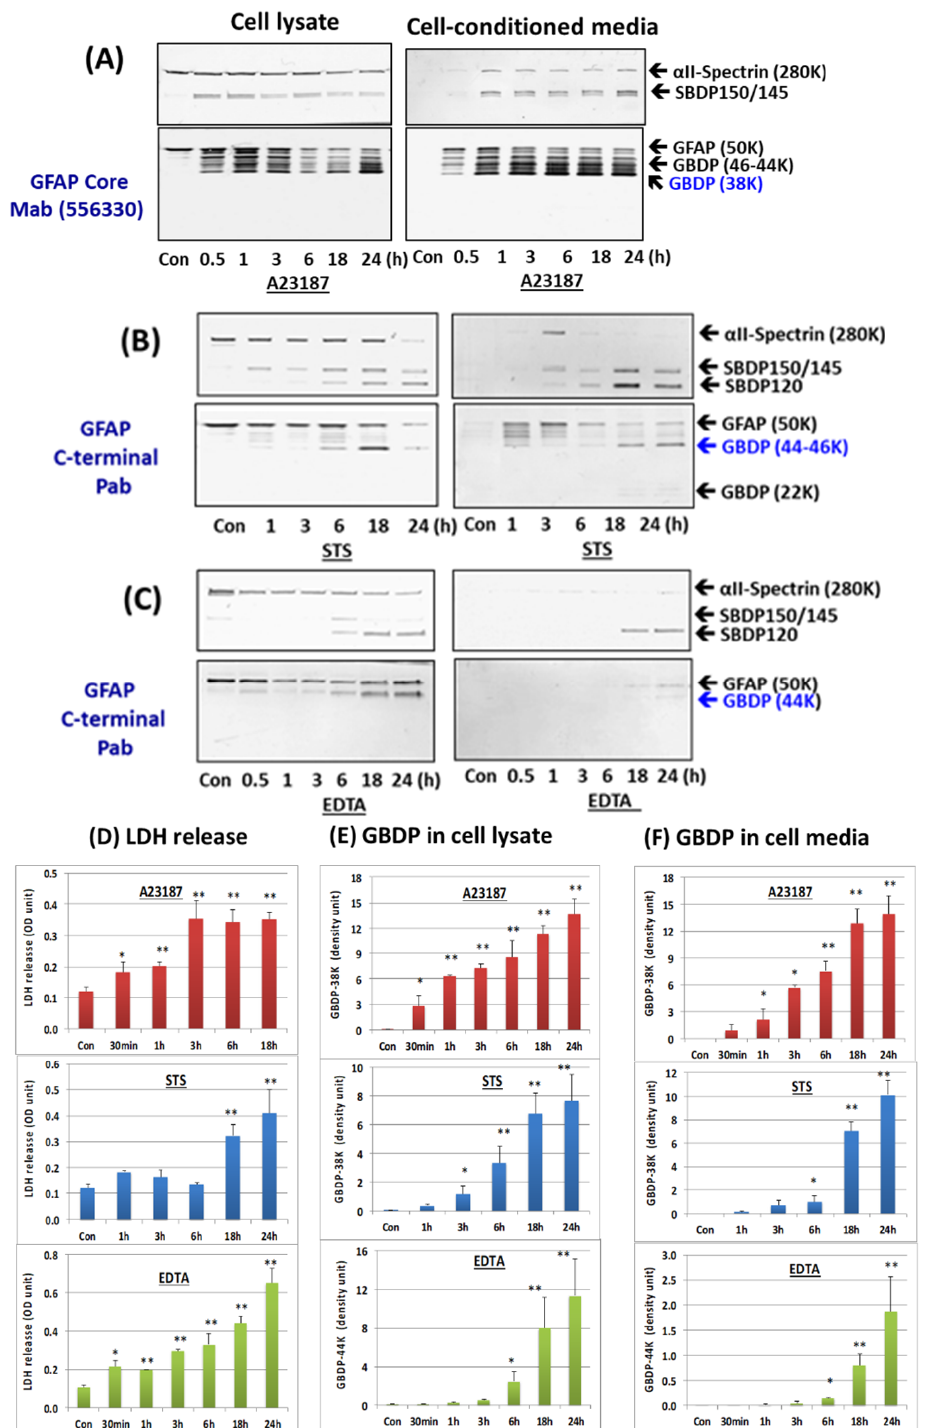
Figure 2. GBDP formation in astroglial cells and release into cell-conditioned media parallel cell injury in primary astroglial culture challenges with pro-necrotic (A23187) and pro-apoptotic cytotoxins (STS, EDTA). ( A ) Cell lysate or cell media probed with αII-Spectrin, GFAP core MAb or GFAP C-terminal PAb. ( B , C ) Quantification of GBDP formation and release parallel astroglial cell injury measured by LDH release with a time course of A23187, STS and EDTA treatment. Panel ( D ) quantification of LDH releases while ( E , F ) are GFAP-38K quantification in cell lysate and cell-conditioned media respectively. Shown are mean ± SEM (n = 4). * p < 0.05, ** p < 0.01 when compared to control (student t -test).